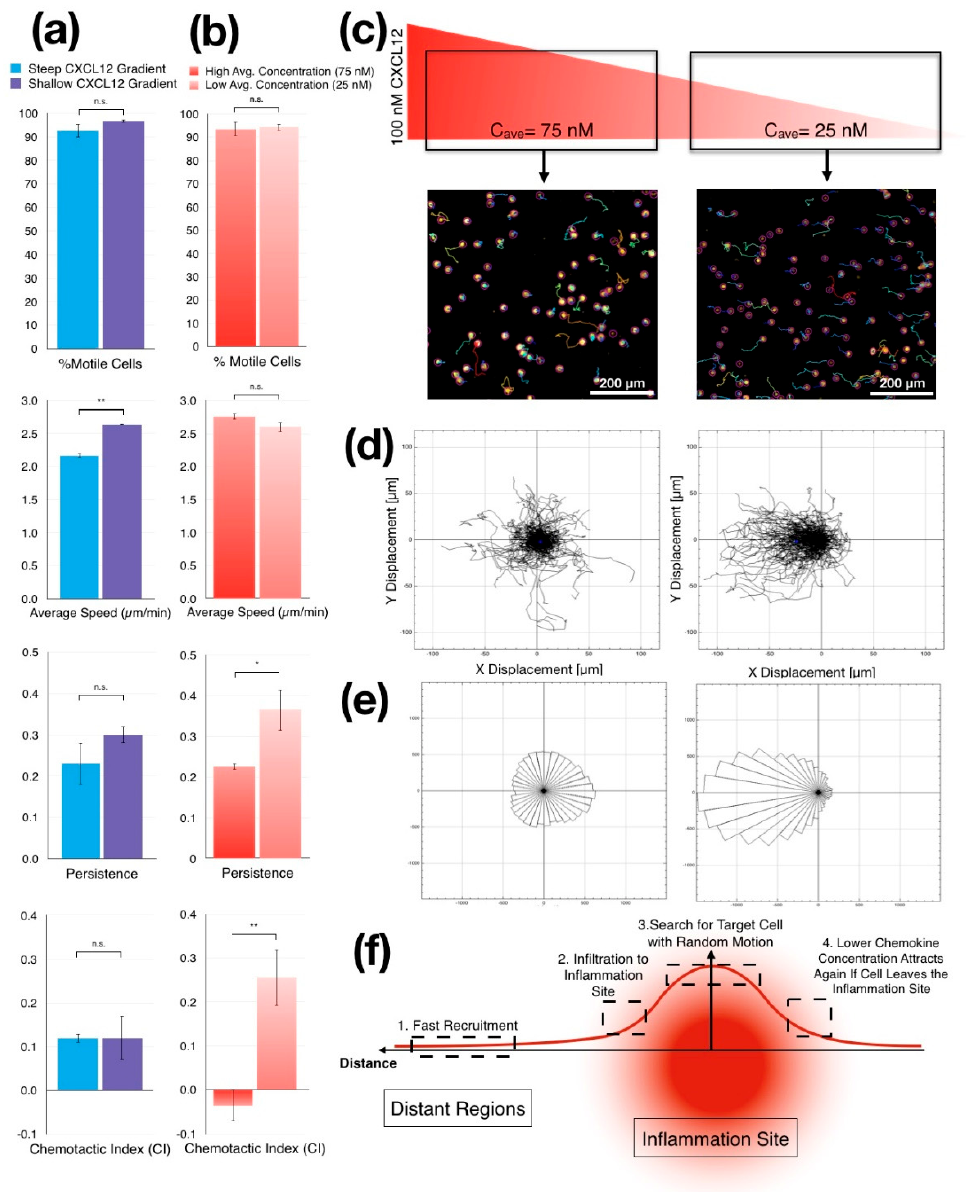
Figure 5. Chemotaxis of Jurkat cells in different CXCL12 gradient modalities ( a ) Quantitative analysis of cell movement shows differences between migration parameters from cells that migrate in shallow CXCL12 gradient (wide chamber, 40 nM/mm) and steep CXCL12 gradient (narrow chamber, 66 nM/mm). Although the increased steepness does not alter the motile cell ratio and chemotactic index, it slows the average speed and persistence of the migration (**p < 0.01 by two-tailed unpaired student's t -test). ( b ) Quantitative analysis shows that average CXCL12 concentration strongly affects the persistence and the chemotactic index of the migrating Jurkat cells, while it does not alter the percentage of motile cells or the average speed of the migrating cells (**p < 0.01, *p < 0.05 by two-tailed unpaired student's t -test). ( c ) We examine our wide gradient chamber by dividing it into two regions with different average chemokine concentrations while maintaining the same gradient steepness. While the region on the left has an average concentration of 75-nM CXCL12, the region on the right has an average of 25-nM CXCL12. ( d ) Spider motility plots of the Jurkat cell chemotaxis in two sub- regions of the wide gradient chamber. While the cells at the higher average CXCL12 concentration (left) appear to be migrating randomly, the ones in the lower average CXCL12 concentration (right) appear to migrate toward the higher concentration of CXCL12 in the gradient. ( e ) Rose plots show the difference between two subregions of the wide gradient chamber in terms of the spreading of